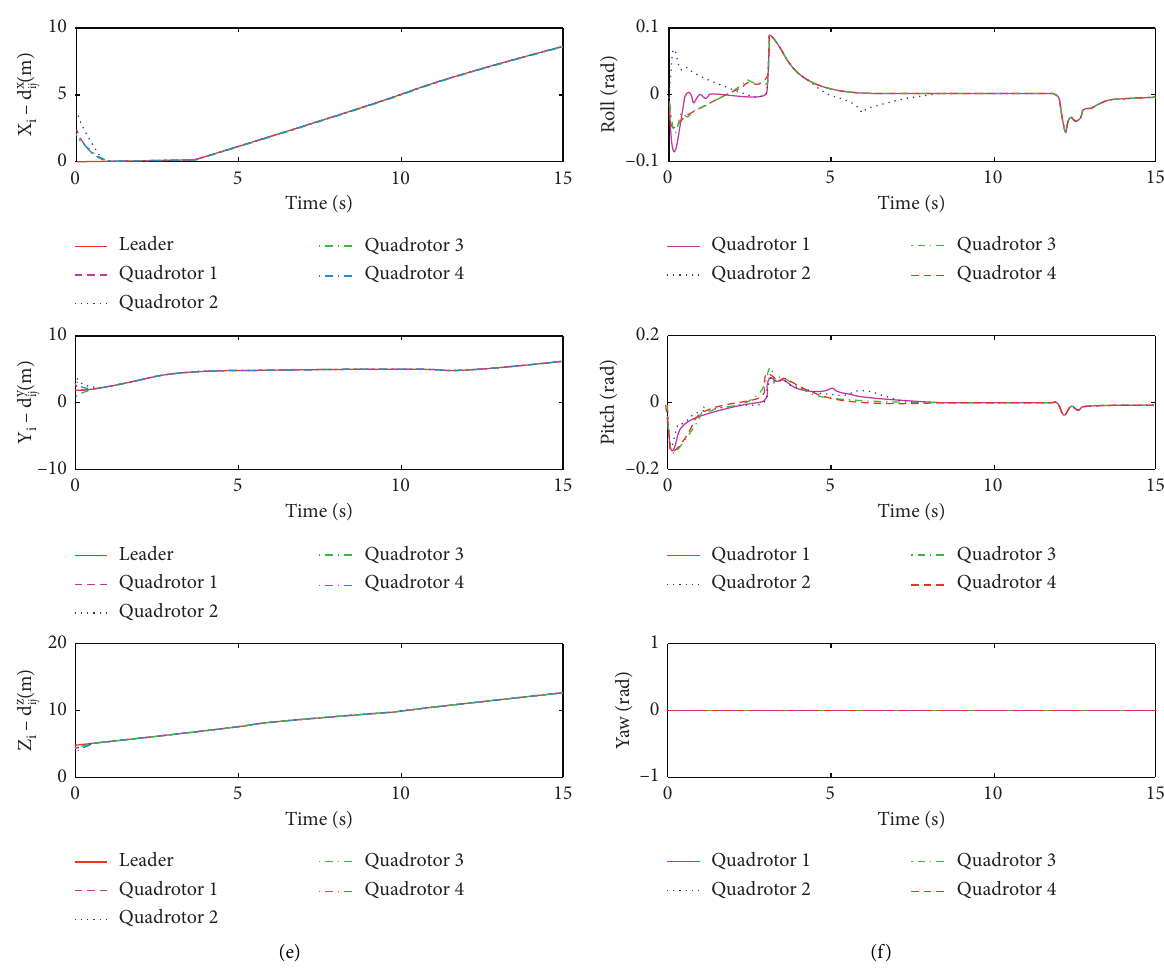
Figure 3: Simulation results. (a) The trajectory of all quadrotors in 3D space. (b) The adjacent distance between every two quadrotors. (c) The virtual velocity of all quadrotors. (d) The real velocity of all quadrotors. (e) The position curves of the leader and the quadrotors. (f) Response of attitude angles of all